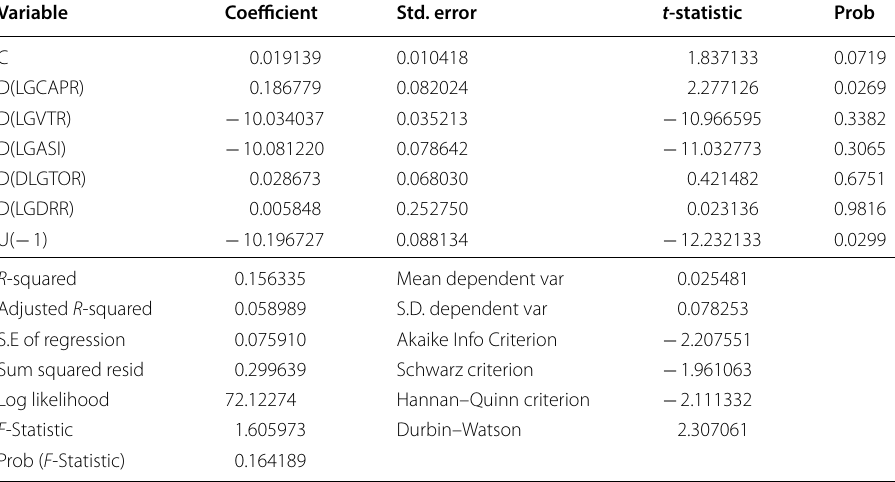
Table 11 Error Correction Model (ECM) results